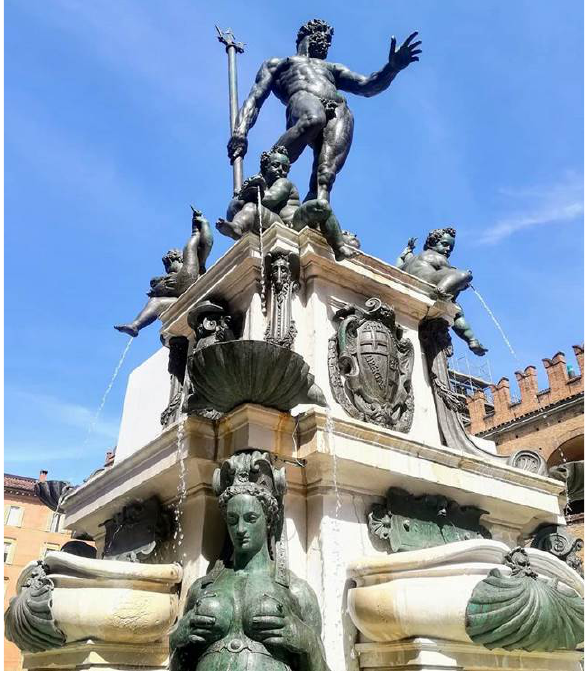
Figure 1. The bronze sculptural groups adorning the Fountain of Neptune in Bologna.